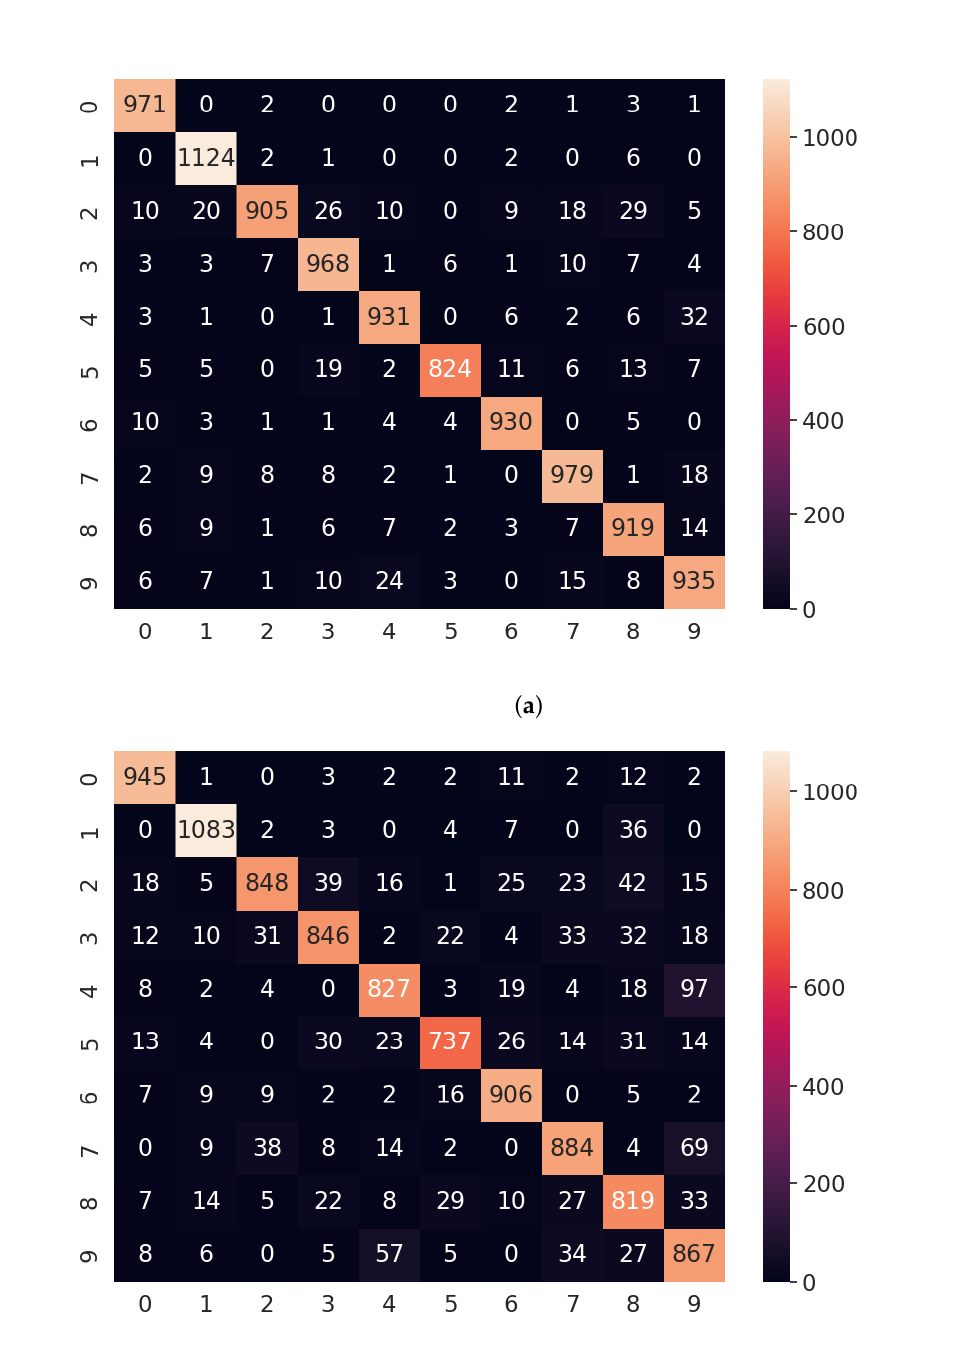
Figure 7. The confusion matrix of a trained architecture on the test set of the MNIST dataset in the case of the reference CNN model ( a ) and in the case of our kervolutional neural network model ( b ). As one can see, the two confusion matrices were qualitatively similar, and although there were more misclassifications in the case of the SAW convolver (which was natural since it had a slightly lower accuracy), the distribution of the errors was